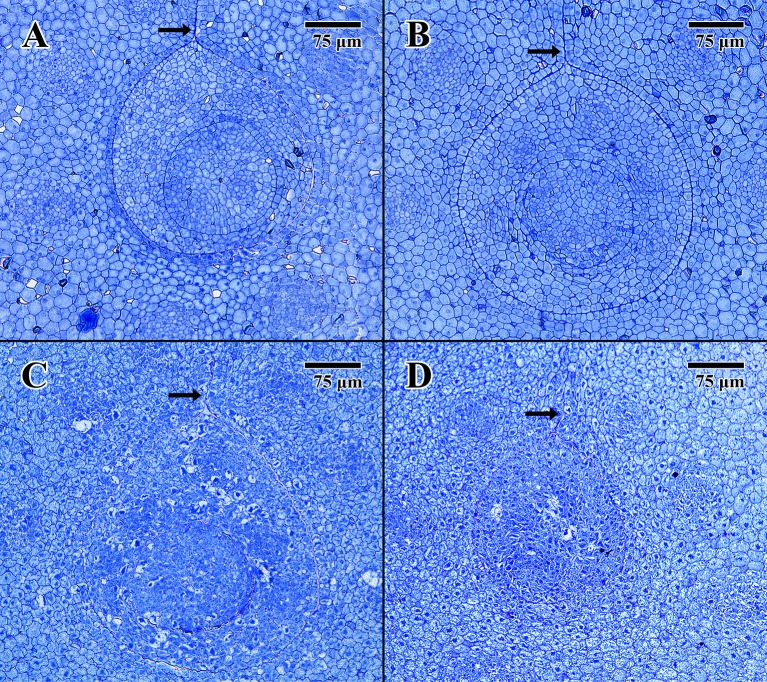
Light microscope micrographs cut 0.5 μm thick at the location of the embryonic pore. (A) Transverse section of 2004 embryo in dry state (MSB accession no. 211945). (B) Transverse section of 2004 embryo in imbibed state (MSB accession no. 211945). (C) Transverse section of 1873 embryo in dry state (EBC accession no. 36007). (D) Transverse section of 1873 embryo in imbibed state (EBC accession no. 36011). (Arrows = pore aperture.) Scale bar = 75 μm.